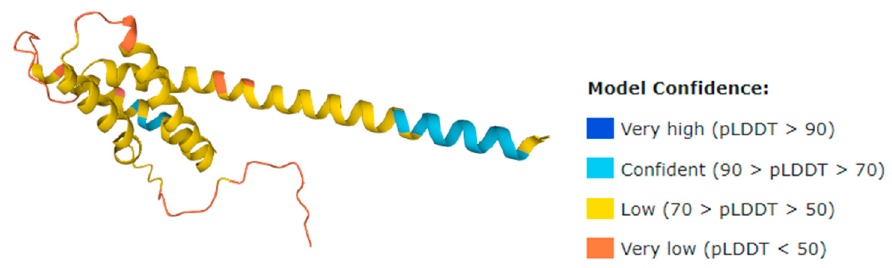
Figure 9. Prolamin in the rice bran product developed based on structure